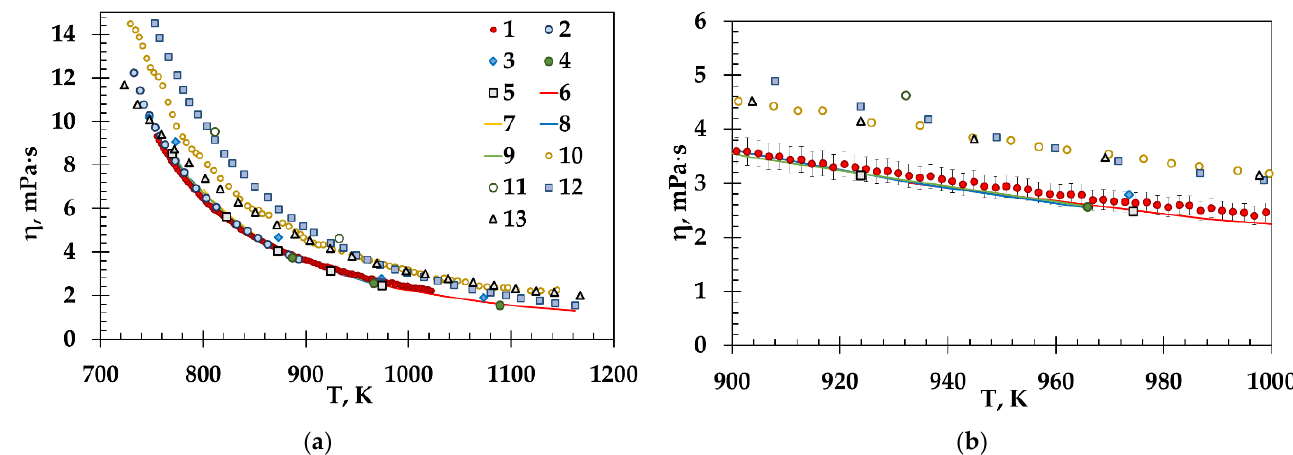
Figure 4. Viscosity of molten (LiF - NaF - KF) eut in the temperature ranges 715—1170 K ( a ) and 900-1000 K ( b ) obtained by different studies: 1—this work, 2—An [17], 3—Cohen [18], 4—Tobias (capil-